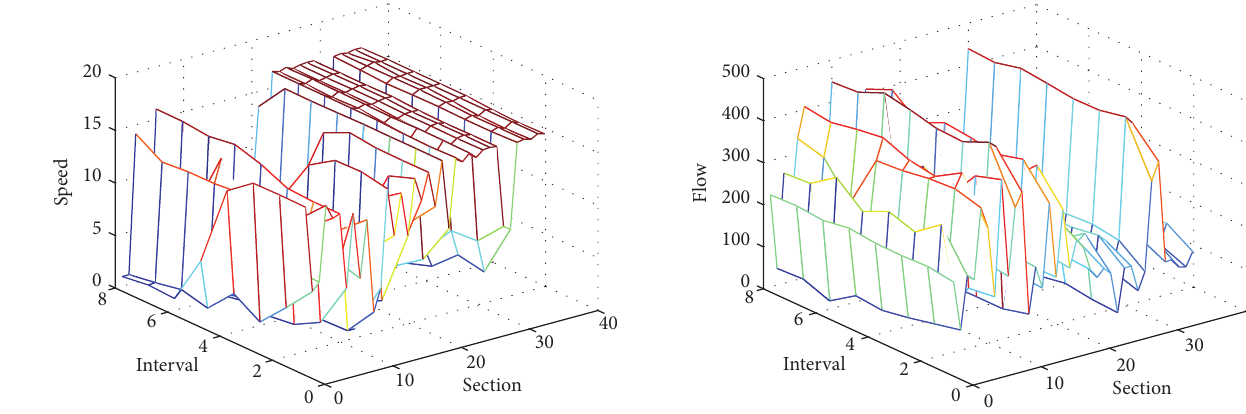
Figure 10: Averaged flow after